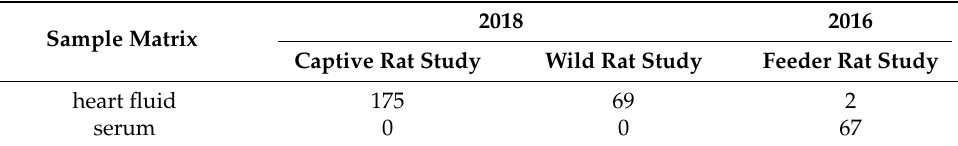
Table 1. Studies and the numbers of rats tested for each study, stratified by sample matrix. Note that in 2016, three additional rats were tested, but those were used as controls for plate-to-plate variation and not included in this